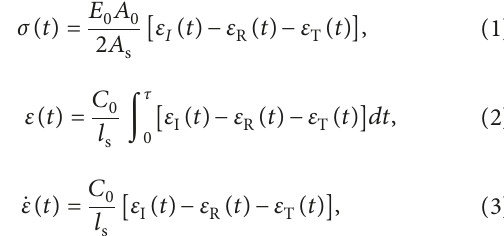
Table 1: wt.% and at.% of blocks in Figure 2(b). Blocks in Figure 2(b) Element wt.%